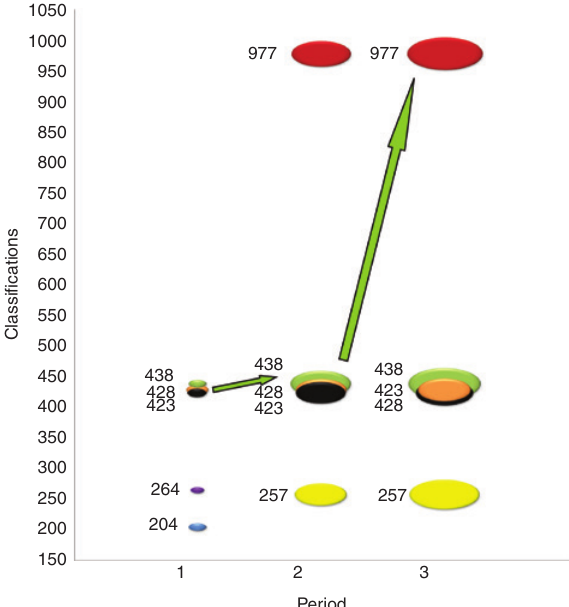
Figure 6: The mainstream technology classifications in three